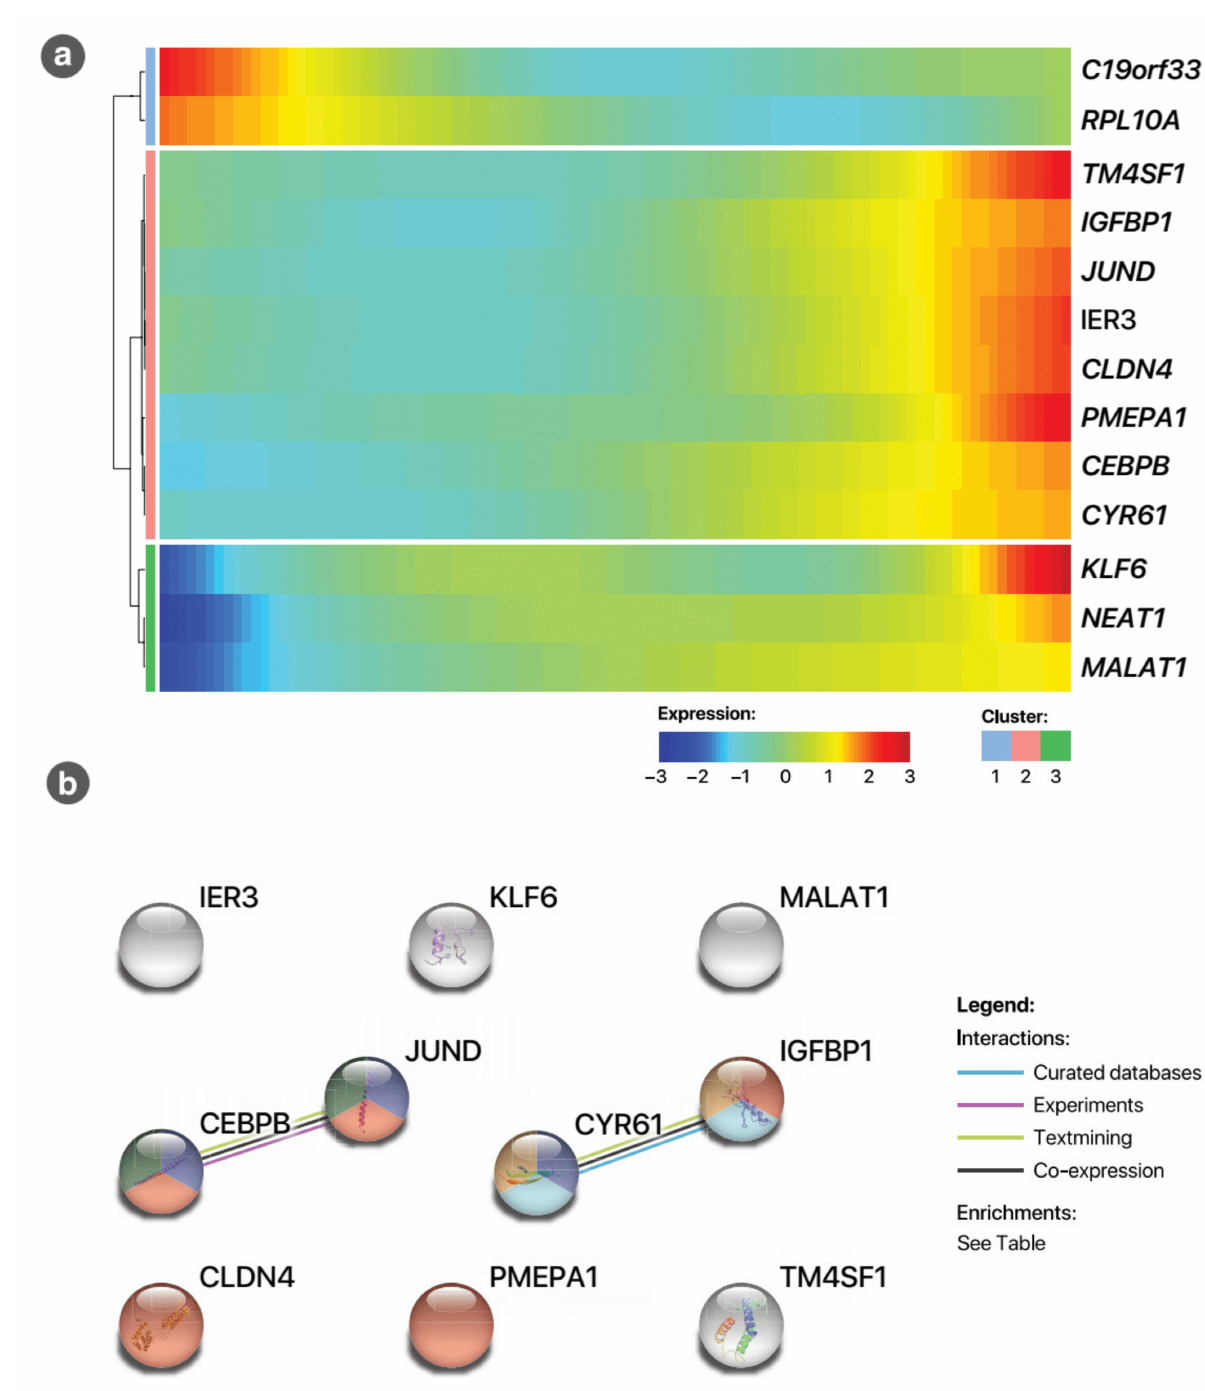
Figure A12. Changes in gene expression with pseudo-time. ( a ) This heat map summarises the genes in PSCs whose expression varied significantly over pseudo-time. ( b ) The same genes represented as a protein network. Each circle (“node”) represents a protein product from the gene while the connecting lines (“edges”) represent interactions between these proteins. The nodes summarises the genes/proteins involved in the enriched pathways listed in Table A9. The colour of the edges represents the nature of the evidence of these interactions (as reported by the STRING database). Overall interaction enrichment p -value was 0.0353, suggesting this group of over-expressed genes are likely to be biologically